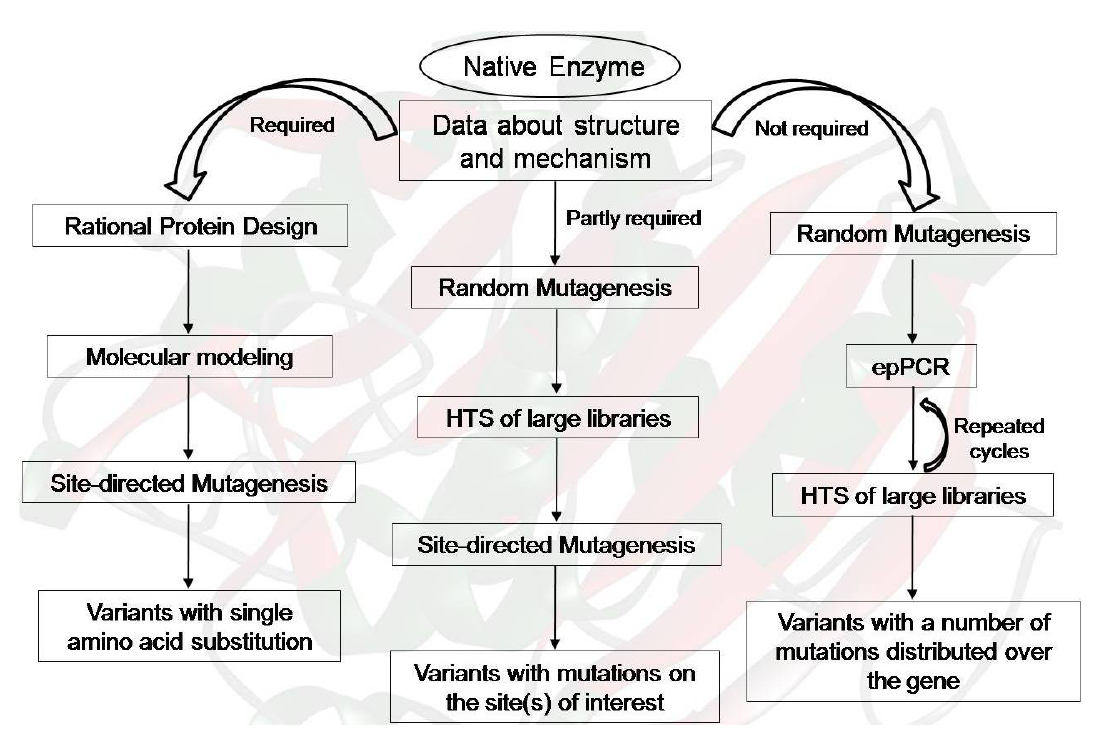
Figure 2. Schematic representation of protein engineering strategies. Engineering method should be selected on the basis of the structural and mechanistic information and the feasibility of a high-throughput screening (HTS) system for screening or